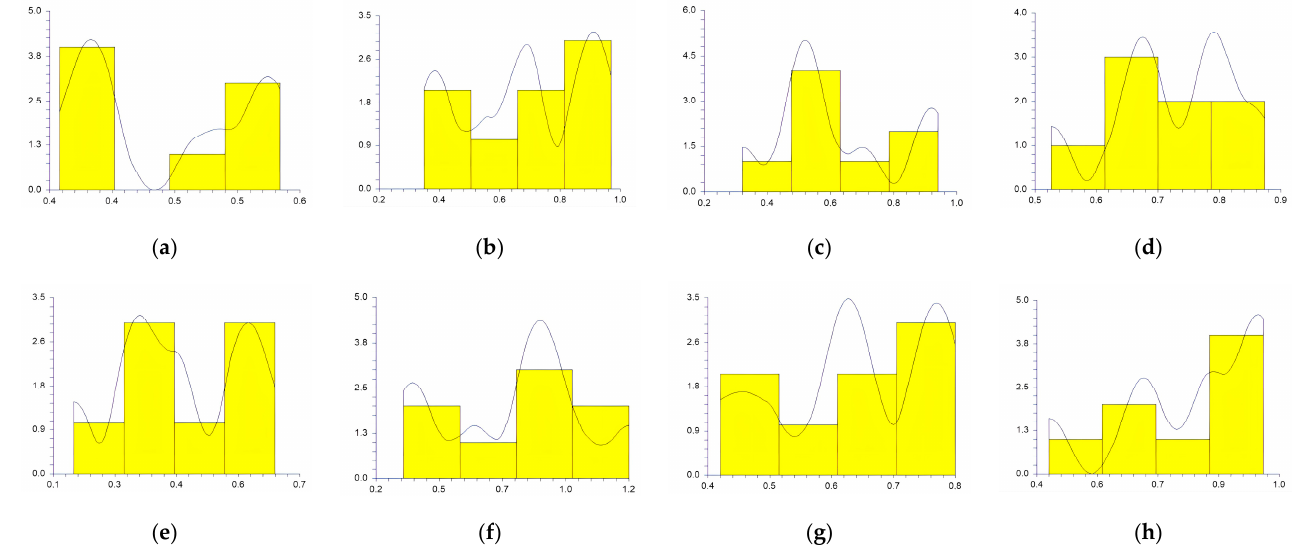
Figure 4. The chamfer width obtained at the reference points by all the participants Tuesday: ( a ) t1 sitting position; ( b ) t2 sitting position; ( c ) T1 sitting position; ( d ) T2 sitting position; ( e ) t1 supine position; ( f ) t2 supine position; ( g ) T1 supine position; ( h ) and T2 supine position.